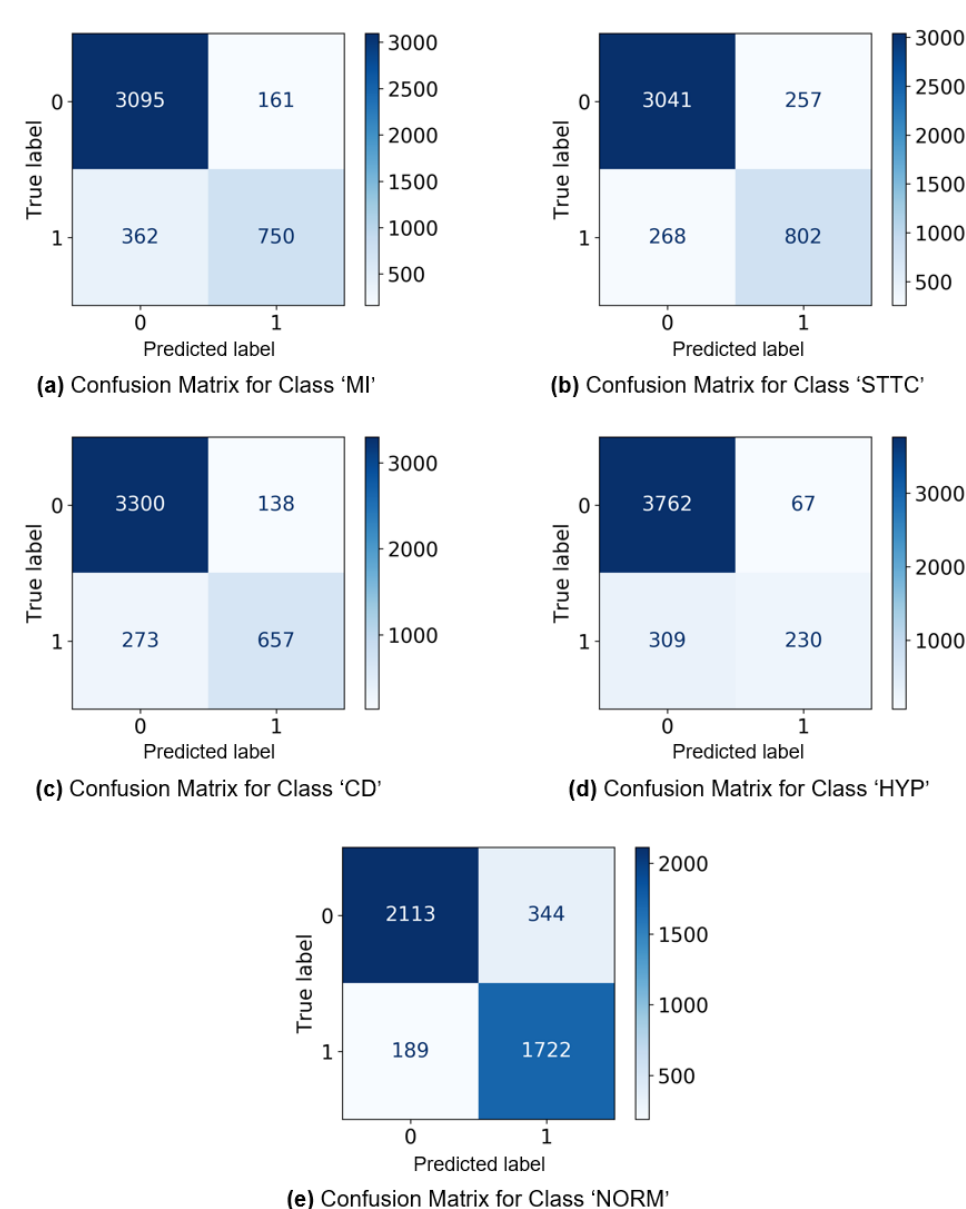
Figure 4. The confusion matrices generated by the proposed model with